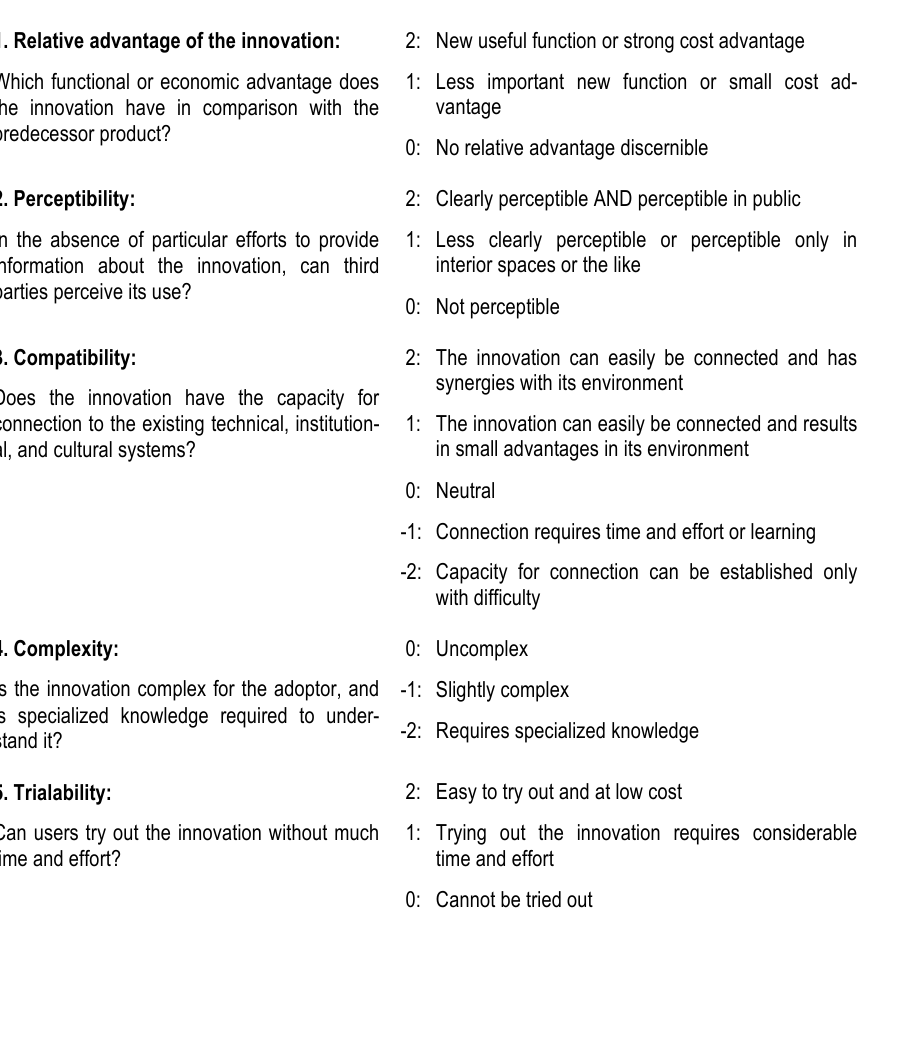
Table 9. Code system for the assessment of factors in diffusion cases Product-related